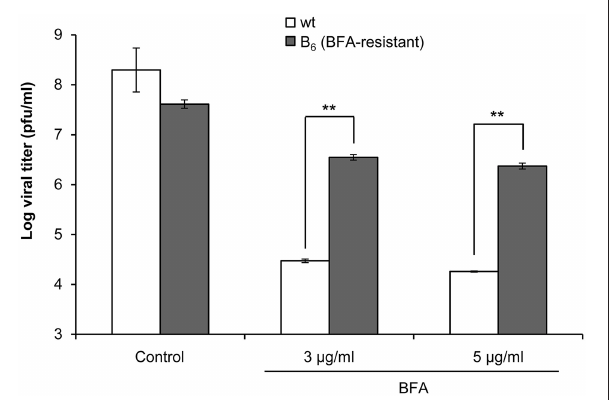
FIGURE 3 | SVDV B 6 is more resistant to BFA than SVDV wt. IBRS-2 cells treated with different concentrations of BFA for 30 min were infected with SVDV wt or SVDV B 6 (moi of 0.5 pfu/cell) in presence of the drug. At 8 h pi the viral titer was determined by plaque assay. Error bars represent SD. Data